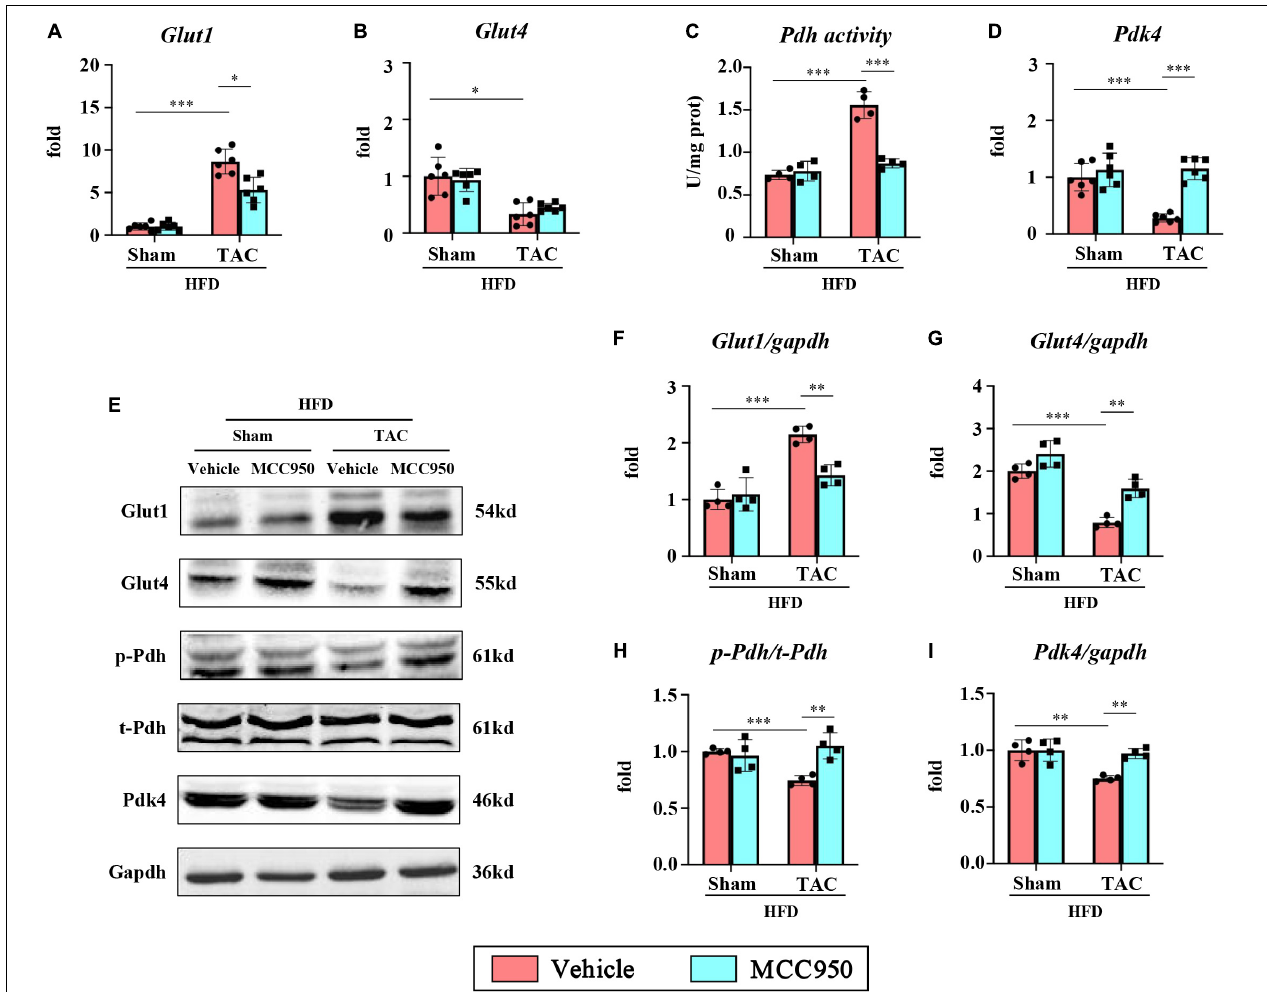
FIGURE 7 | MCC950 regulated the gene expression relevant to glucose metabolism in obese mice after TAC surgery. Relative mRNA expression of (A) GLUT1 and (B) GLUT4, n = 6. (C) PDH activity in the cardiac tissue, n = 4. (D) Relative mRNA expression of PDK4, n = 6. (E–I) Representative blots and quantitative analysis showing the expression levels of GLUT1, GLUT4, p-PDH, t-PDH, and PDK4, n = 4. GLUT, glucose transporter; PDH, pyruvate dehydrogenase; PDK, pyruvate dehydrogenase kinase. ∗ p < 0.05, ∗∗ p < 0.01, ∗∗∗ p <